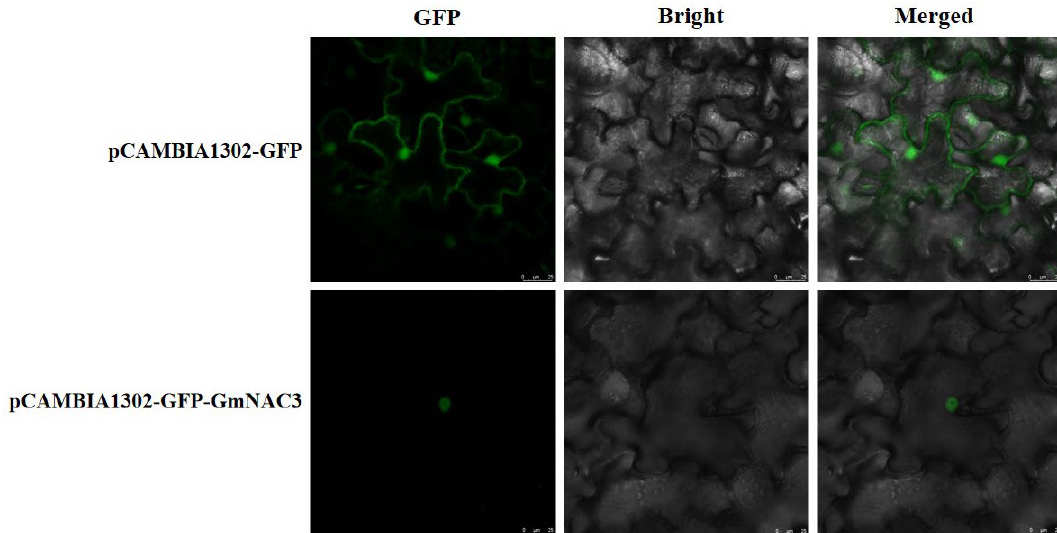
Figure 6. Subcellular localization of GmNAC3 based on the transgenic Nicotiana benthamiana showing the transient expression of GmNAC3 fusion protein and green fluorescent protein (GFP) observed using the laser confocal microscopy. GFP: GFP fluorescence; Bright: bright field; Merged: the superposition of both bright and GFP fluorescence fields. pCAMBIA1302–GFP: control; pCAM-